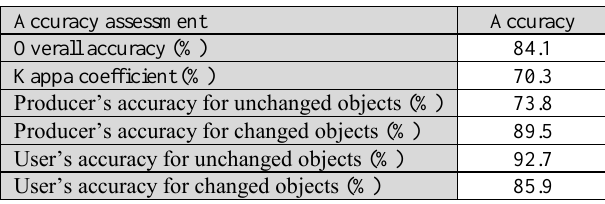
Table 10. Change detection accuracy